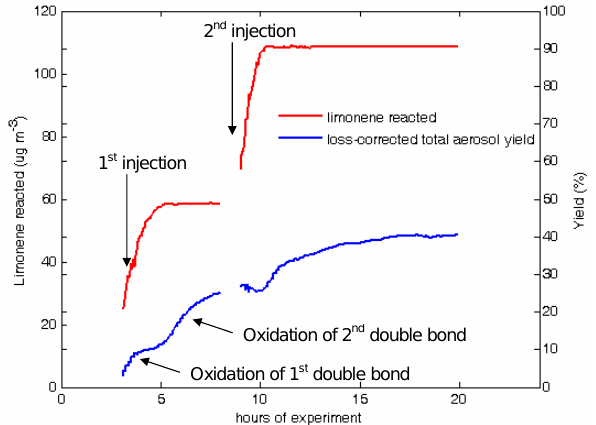
Fig. 2. Total limonene reacted and time-dependent, loss-corrected total aerosol yield for the two limonene injections. Increase in yield after limonene is depleted indicates that reaction at the second double bond in first-generation oxidation products produces aerosol. for the second injection. The final SOA yields observed (Fig. 2) at the peak aerosol concentration following each injection were 25% for the first injection and 40% after the second injection, sug- enhanced partitioning to the aerosol phase. 215